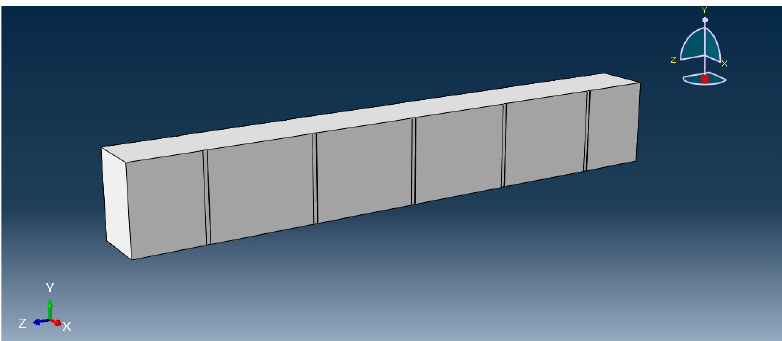
Figure 6. Concrete part for unaligned carbon fiber scheme.